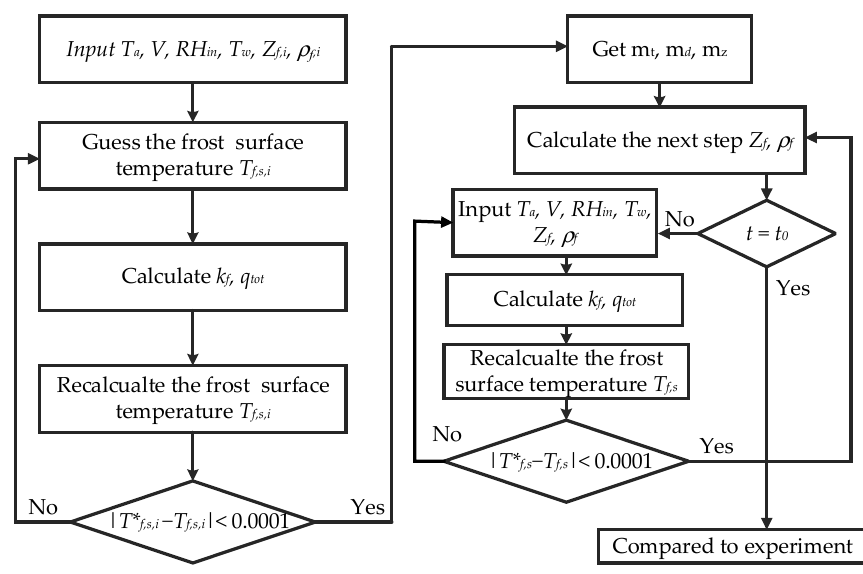
Figure 5. Schematic of the physical model and boundary conditions. Figure 5. Flowchart of iterations in the predictive model for